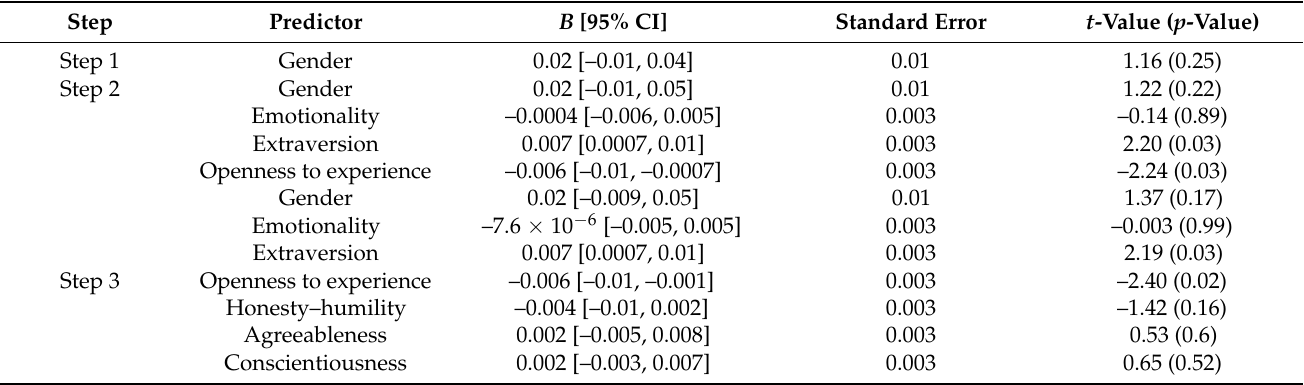
Table 4. Results of the hierarchical regression analysis with the adaptation of trust behavior in the untrustworthy condition as the outcome